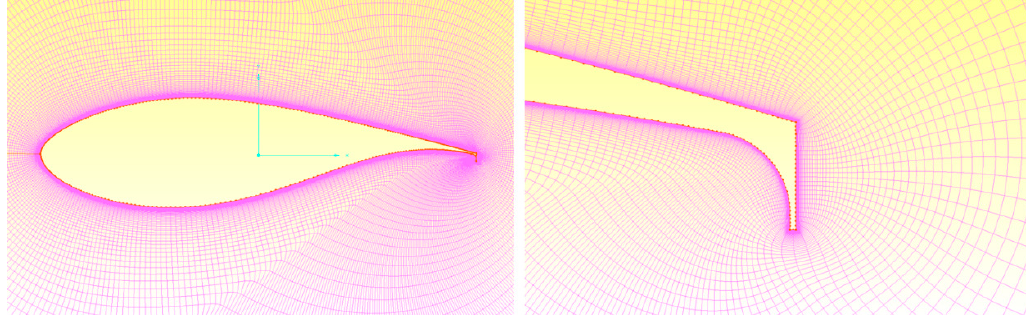
Figure 2. Mesh distribution on the DU91W(2)250 and on the airfoil trailing edge with a Gurney Flap.